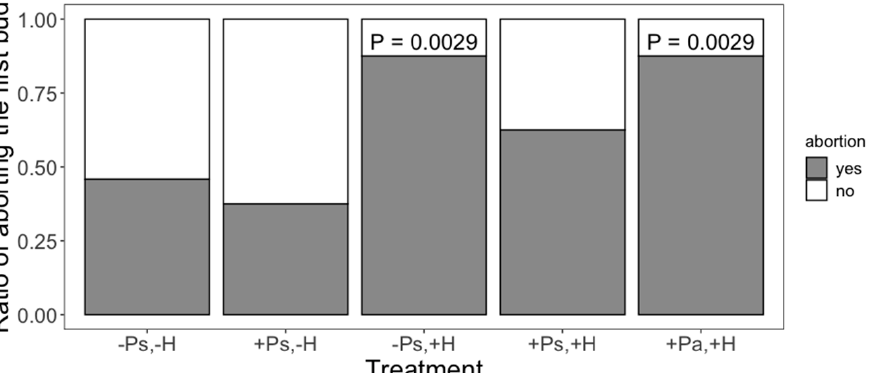
Figure 1. Effect of both priming (P) and herbivory (H) on the likelihood of aborting the first bud. Plants were more likely to abort when damaged if they received no priming or the priming came from an allopatric insect. Plus (+) and minus ( − ) signs denote the presence/absence of the treatment; Ps and Pa denote priming being performed by a sympatric or allopatric insect, respectively. There were 24 replicates (plants) per treatment ( n = 120).